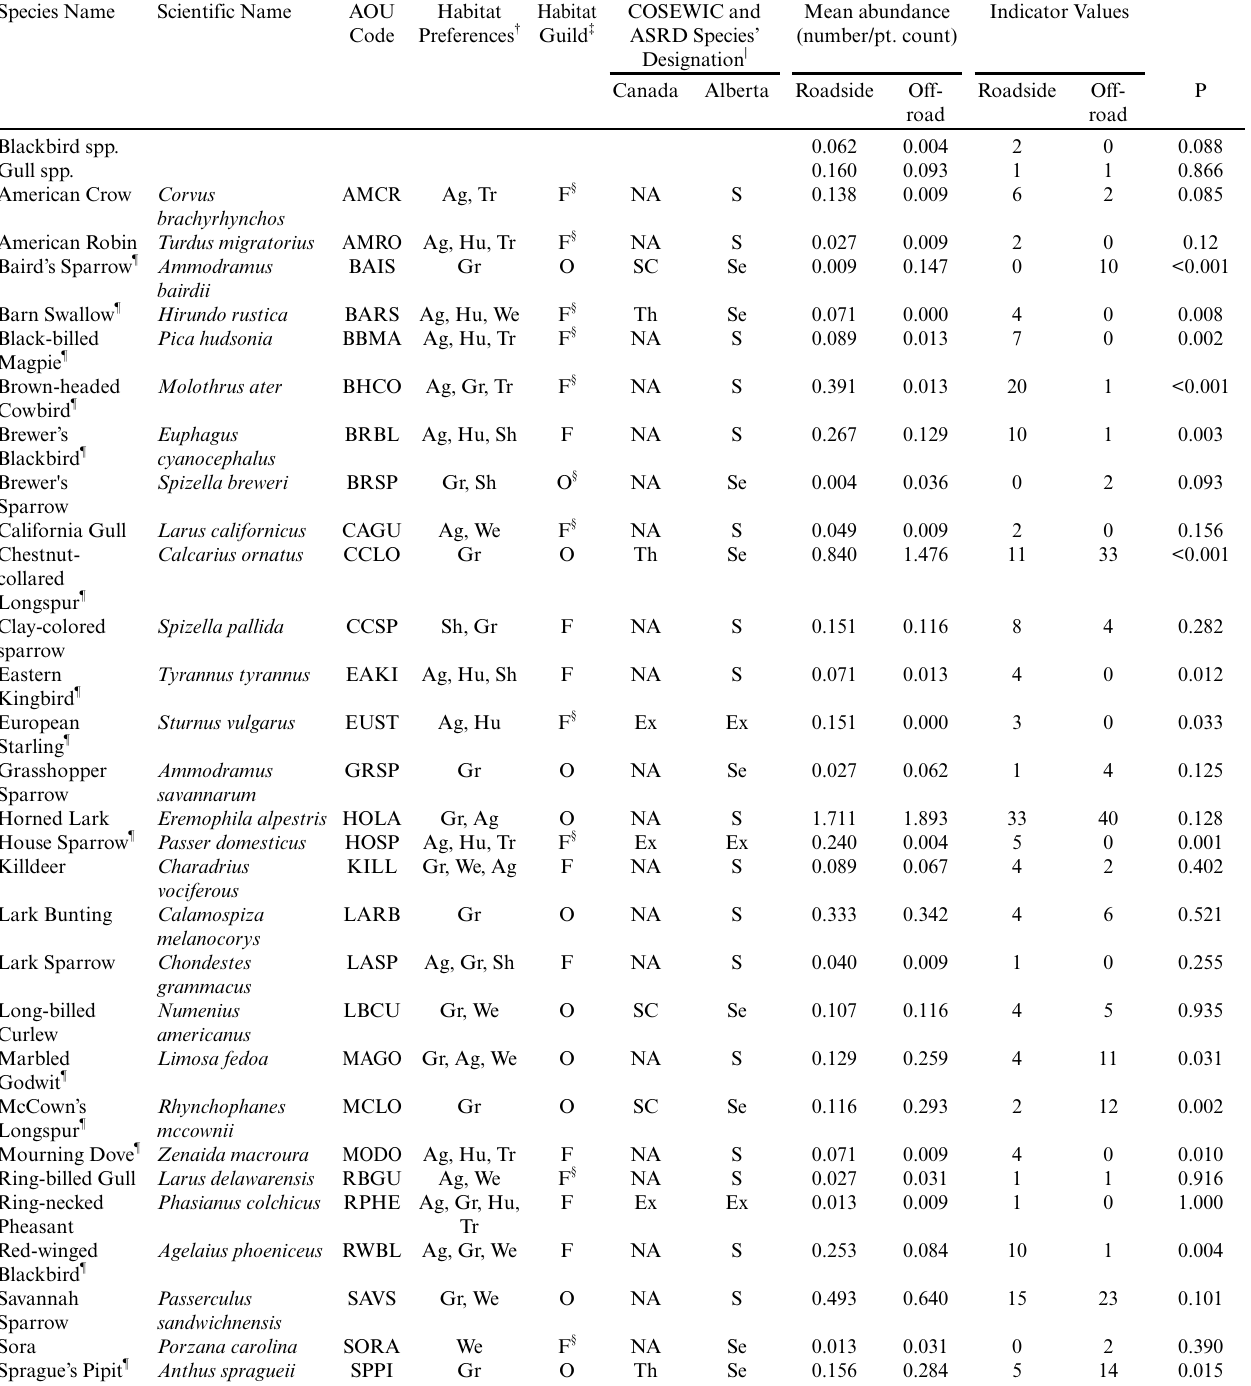
Table 2 . Habitat preferences, habitat guild, Canadian and Albertan population status designation summary statistics, mean abundance per point count, and Indicator Values, significance ( P ) of Indicator Species Analysis and four-letter American Ornithologists Union (AOU) code for species detected on surveys in the Prairie Ecozone of southern